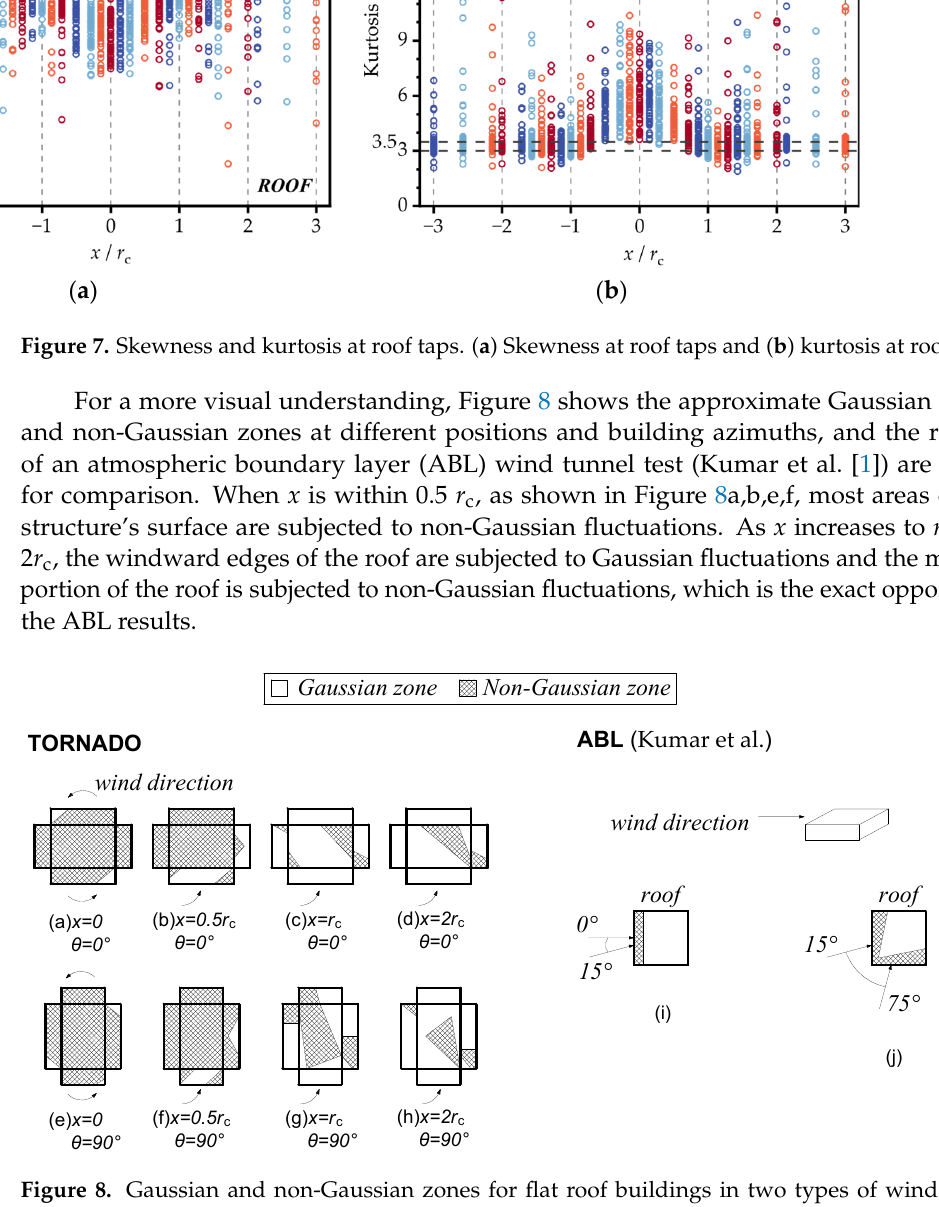
Figure 9. Normalized wind pro fi les of the tornado-like vortex and atmospheric boundary layer wind. The wind pro fi le of the ABL is derived from Levitan et al. [26]. 4.2. Extreme Value Estimating of Tornado-like Pressure According to the classical extreme value theory, for a large number of independent identically distributed samples, their peak values can possibly be presented by any one of the extreme value distributions: Type I, II, or III. For wind loads, Type I, also called the Gumbel distribution, can describe the probability density of its extreme values. The gen- eral expression for the cumulative density function (CDF) of the Gumbel distribution is: ( ) X F x x μ β =exp{-exp[-( - )/ ]}